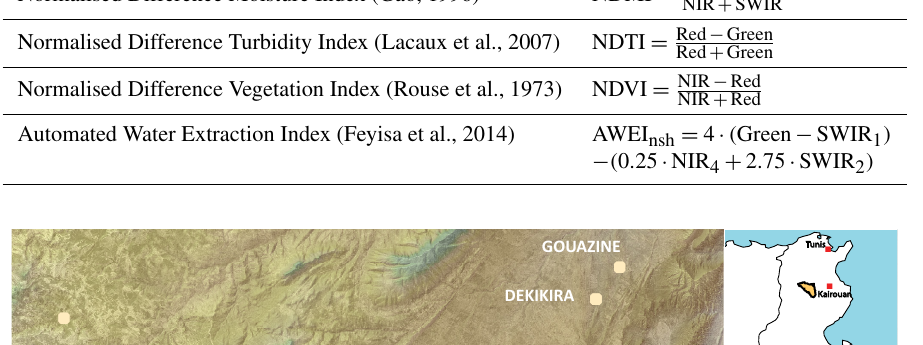
Green + NIR Green + SWIR SWIR + Green NIR + SWIR Red + Green NIR + Red